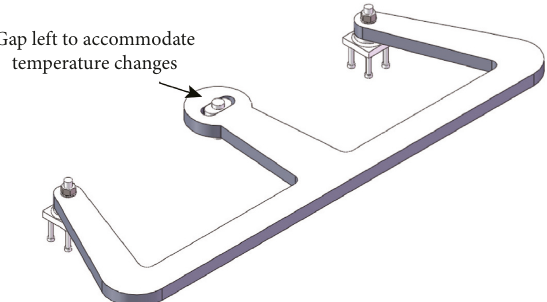
Figure 6: Configuration of the E-shaped damping